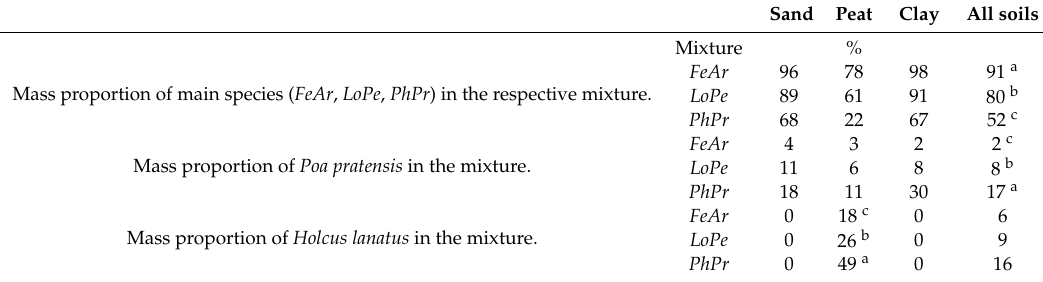
Table 2. Mass proportions (%) of the sown grass species FeAr , LoPe , PhPr and PoPr and of the invading species Holcus lanatus on the di ff erent soil types. Lsmeans averaged over the three types of managements (grazing, combined, and cutting-only) after three years. Sand Peat Clay All soils Mixture % FeAr Mass proportion of main species ( FeAr , LoPe , PhPr ) in the respective mixture. Mass proportion of Poa pratensis in the mixture. Mass proportion of Holcus lanatus in the mixture. Different letters indicate significant differences ( P < 0.05) among 1. the mean mass proportions of the main species averagedoverthesoil(row1, column6), 2. themeanmassproportionsof Poapratensis inthetreemixturesaveragedover the soil (row 2, column 6), 3. the mean mass proportions of Holcus lanatus in the three mixtures on clay and 4. the mean mass proportions of the main species on the three soil types averaged over the main species. FeAr : Festuca arundinacea , LoPe : Lolium perenne , PhPr : Phleum pratense